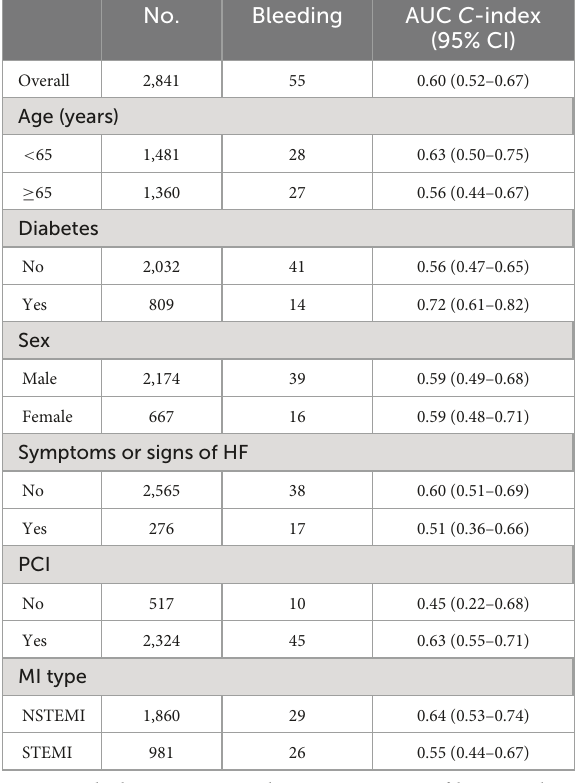
TABLE 2 AUCs of SS among the overall population and subgroups. ( Figure 3 ). After analysis, 1,085 patients had a threshold probability ranging from 0.4 to